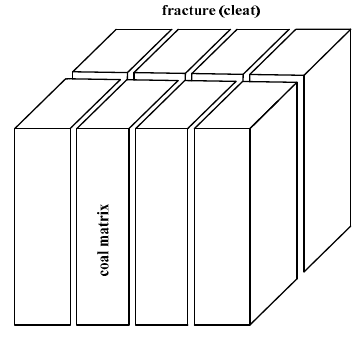
Figure 2. A matchstick model of a coal seam.